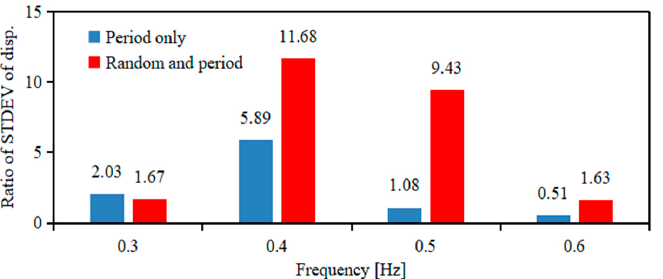
Figure 16. Results of comparing Ratio of displacement standard deviation of mass block to support point. (The blue graph is the result of vibration with a periodic signal. The red graph is the result of vibration with random and periodic signals.)